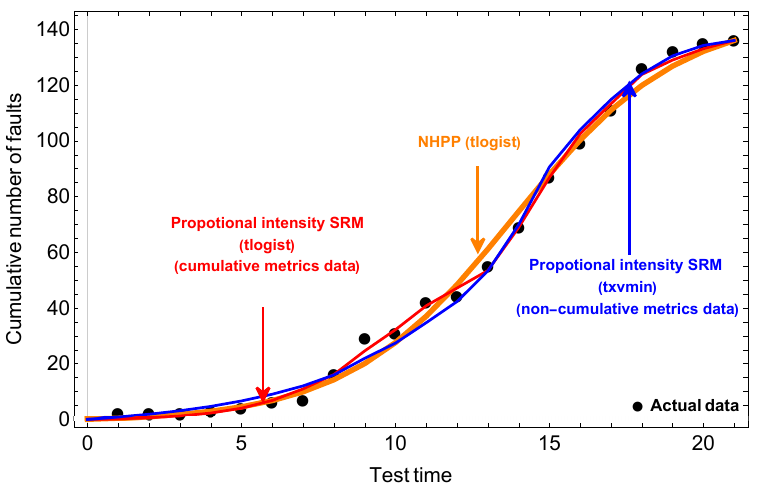
Figure 1. Behavior of estimated cumulative number of software faults in